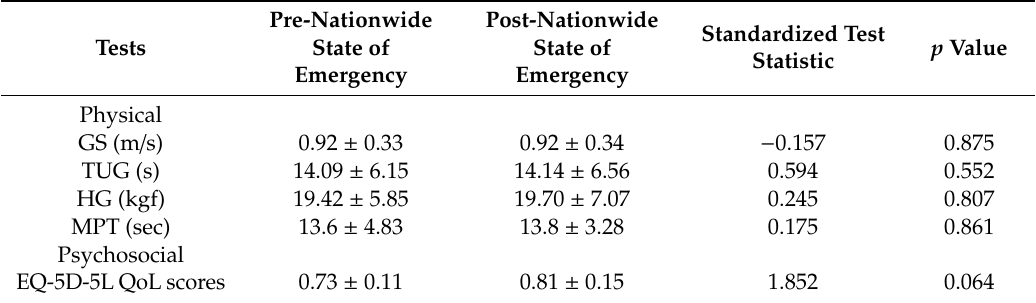
Table 1. Differences in results of physical and psychological testing between the pre- and post-nationwide state of emergency. Post-Nationwide Pre-Nationwide Standardized Test p State of Tests State of Statistic Emergency Emergency